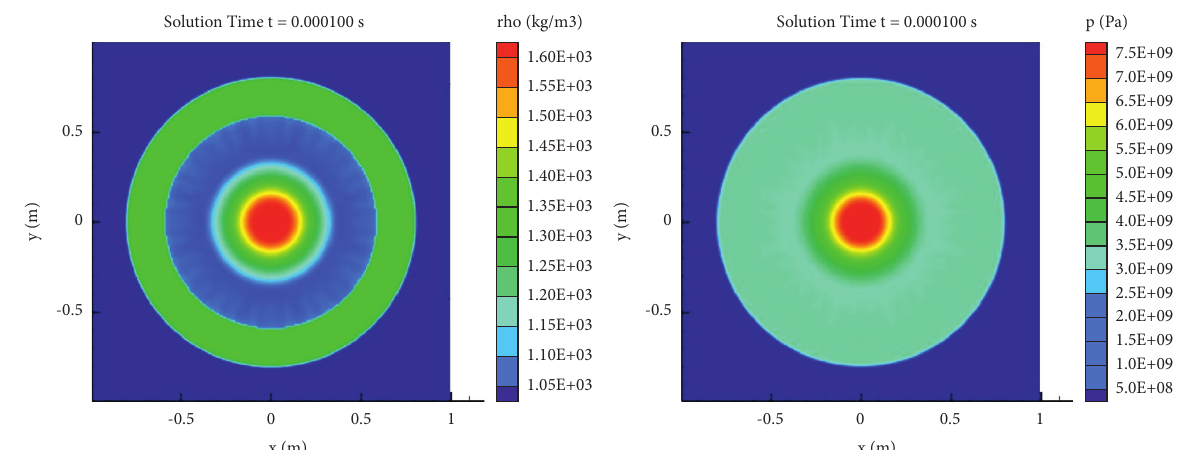
Figure 11: Density and pressure contours of Case 3 at 0 . 1 × 10 − 3 Figure 13, which indicates a good match among 3D, 2D axisymmetric and 1D spherical solutions. Contours of density and pressure produced by 2D axisymmetric and 3D solvers are plotted in Figures 14 and 15, respectively. The multidimensional results are consistent with their respective xy -plots in Figure 13. No contour distortion occurs and symmetry is good.